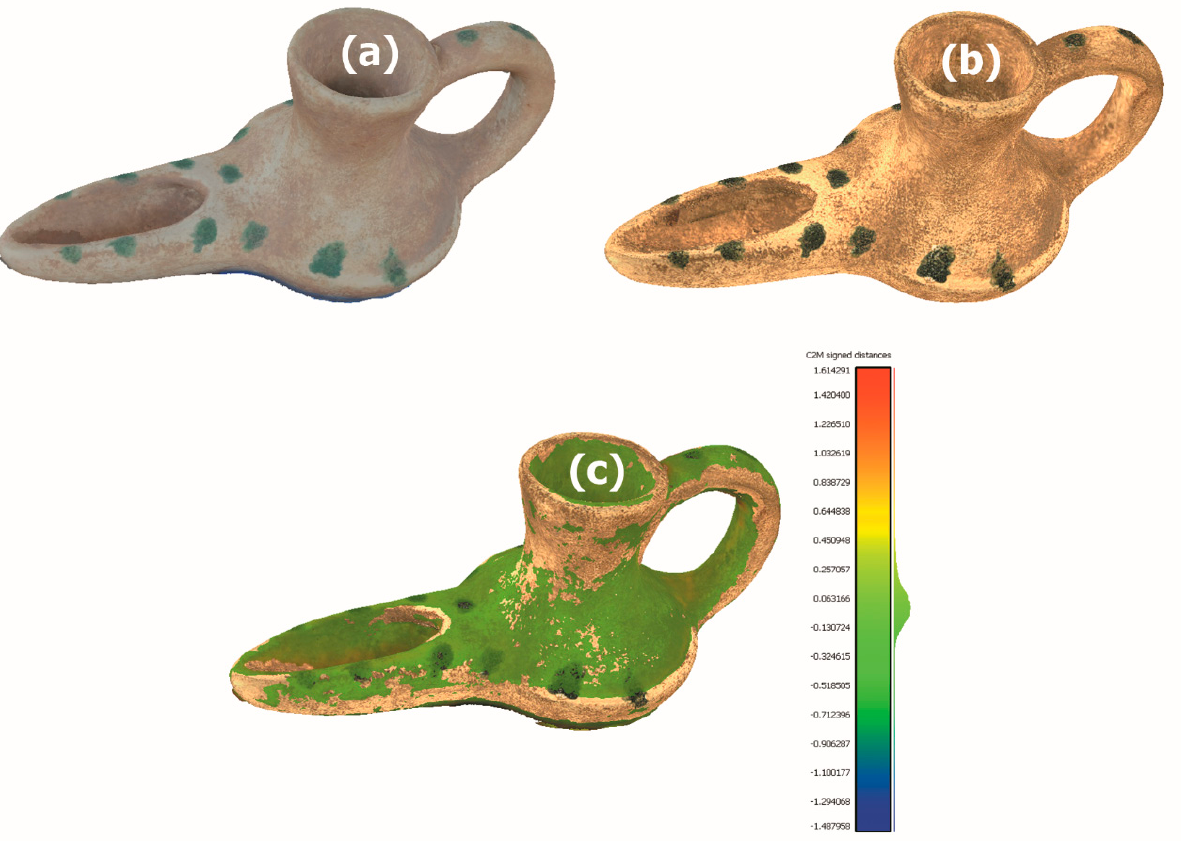
Figure 14. ( a ) Meshes Captures with photogrammetry ( b ) Meshes Captures with scanner Artec Spider ( c ) Corporate image with colour on mesh. (Source: self-made).